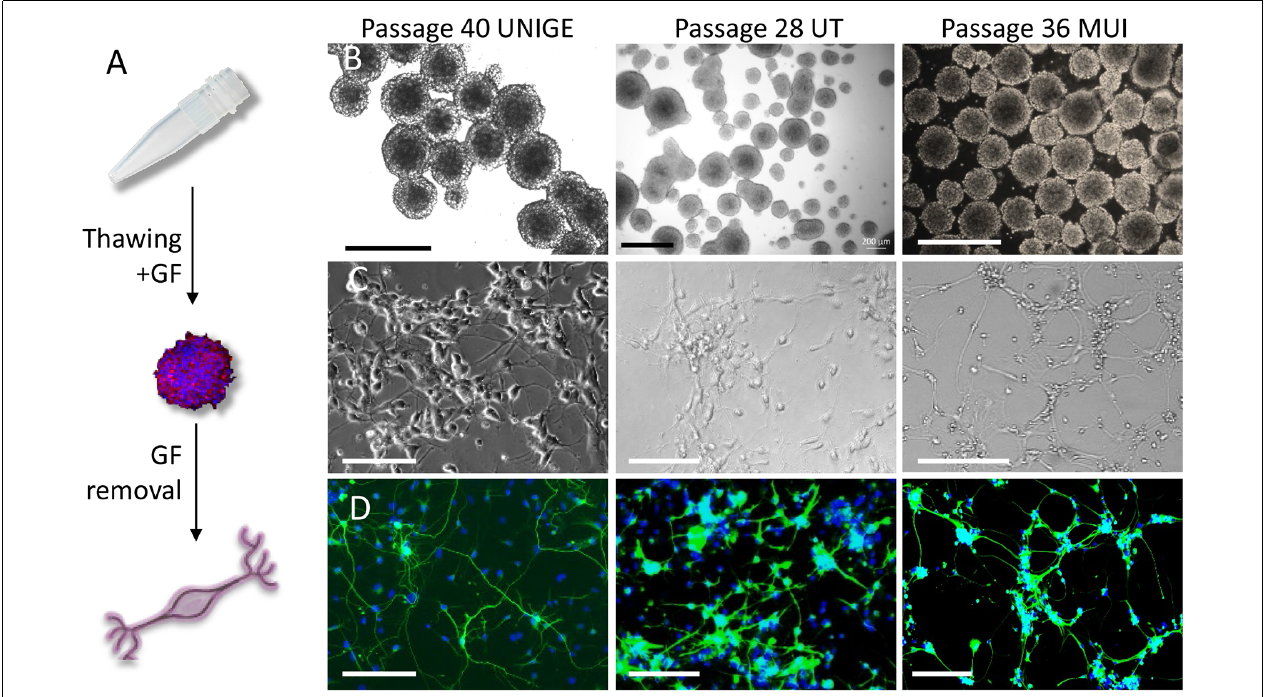
FIGURE 2 | Propagation and differentiation of phoenix auditory neuroprogenitors following freezing/thawing cycles. (A) Upon thawing, progenitors rapidly form highly propagating auditory neurospheres, which can be easily differentiated into auditory neurons like cells with appropriate coating and growth factor removal. (B) Bright-field microscopy pictures of phoenix neuroprogenitors as cultured at the indicated passage in ultralow attachment flasks following freezing and thawing cycles in three different laboratories. Scale bar: 500 µ m. (C) Bright-field pictures and (D) BIII-tubulin staining of differentiated auditory neurons on Matrigel. Scale bar: 100 µ m. At any passage in each of the three institutions, phoenix neurospheres were differentiated into auditory neuronal cells exhibiting a majority of bipolar neurons. UNIGE, University of Geneva; UT, University of Tübingen; MUI, University of Innsbruck.